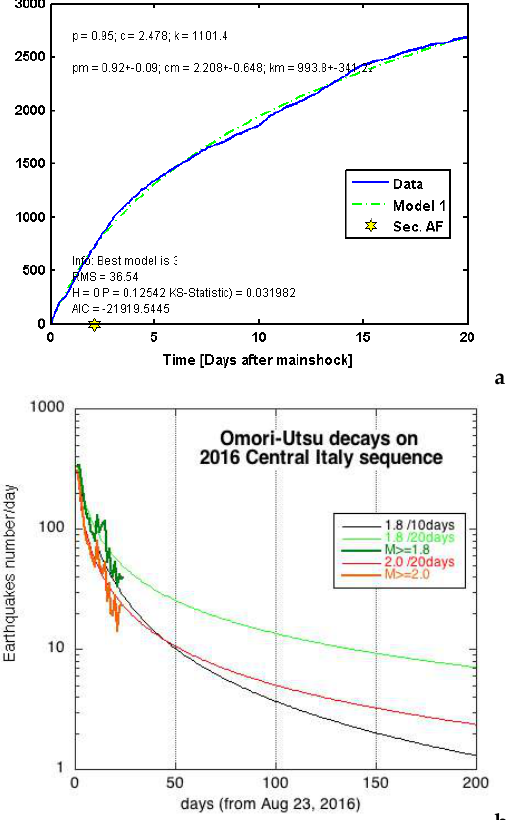
Figure 4: Omori-Utsu decay for the 2016 sequence: a) fit on the first 20 days of INGV bulletin data with M ≥ 1.8; b) observed versus predicted n(t) from Aug 23 until Sep 16 (24th day), Model 1 of Fig. 4a by light green